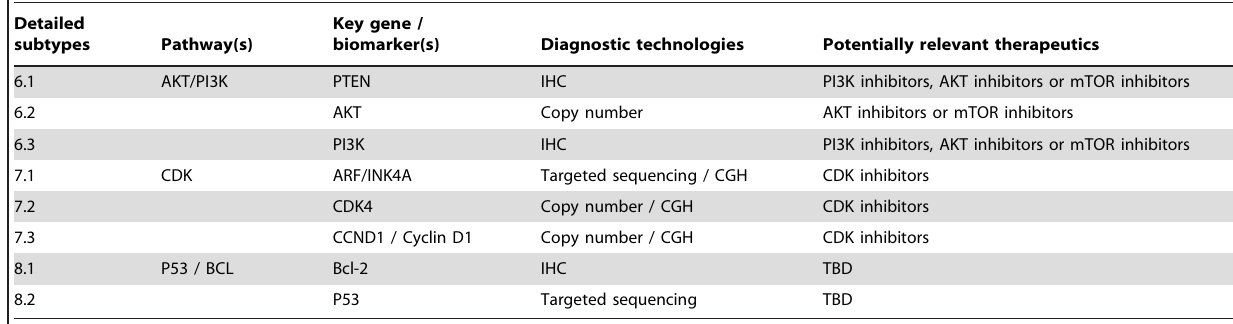
Table 2. Secondary melanoma molecular